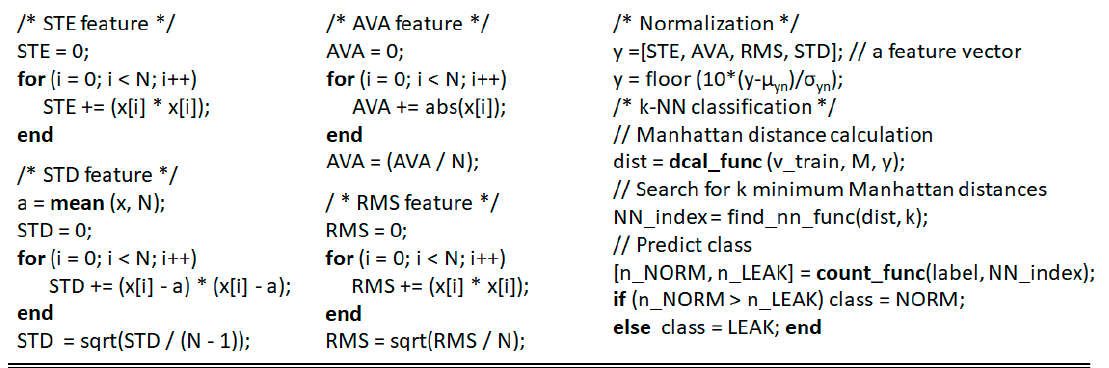
Figure 8. Primary program module of real-time gas pipeline leak detection embedded in the 32F746G-DISCOVERY board.